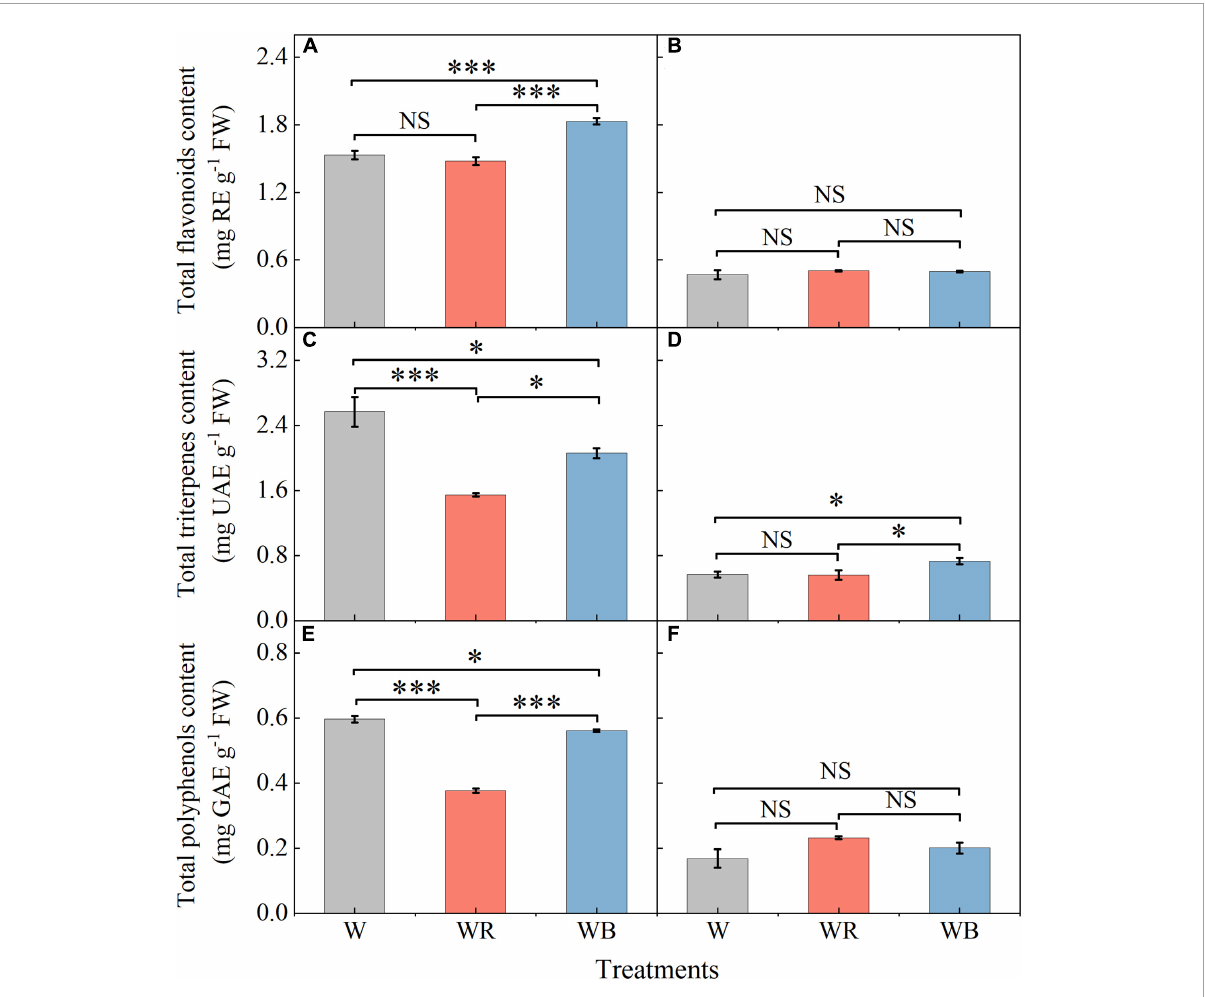
FIGURE4 The contents of total flavonoids, triterpenes and polyphenols in extracts of wheat seedlings leaves (A,C,E) and stems (B,D,F) under different treatments. Values represent the mean ± SE ( n = 3). The symbols ∗ and ∗∗∗ indicate significance at the 0.05 and 0.001 levels, respectively. NS, not significant, according to the Duncan’s